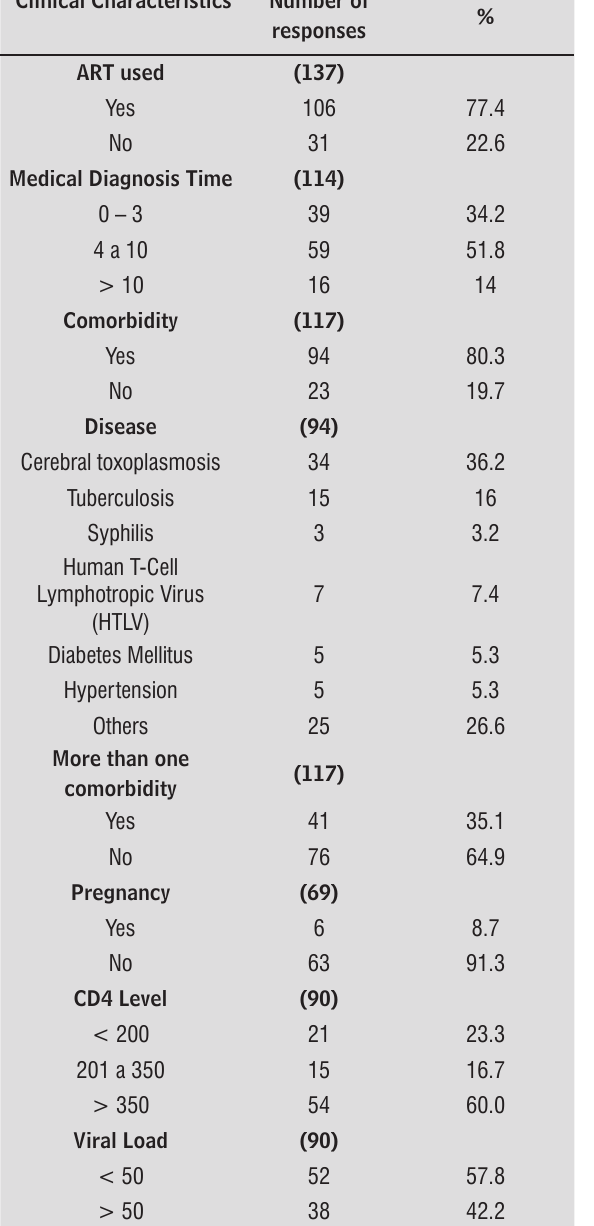
Table 2 - Clinical Characteristics and effects of the disease of infected users with HIV in a Physiotherapy Department in a Specialized Reference Center in